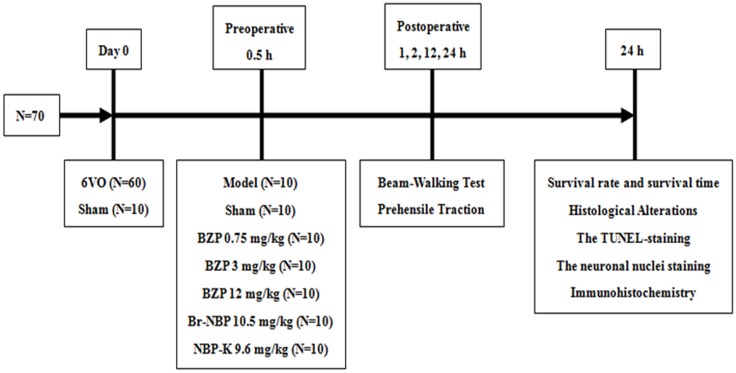
The study design.